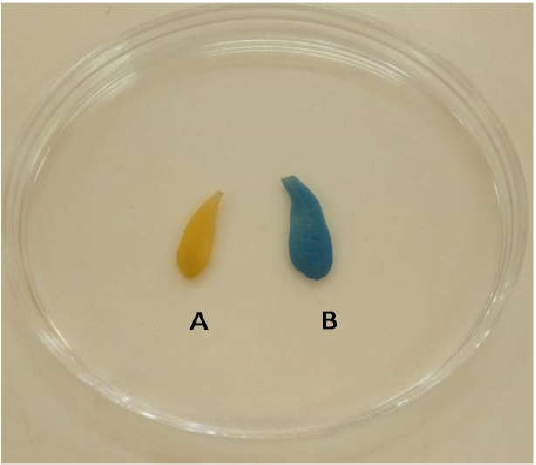
Fig. 4 Histochemical GUS staining: A) Leaves from a non-transgenic plant; B) Leaves from transgenic